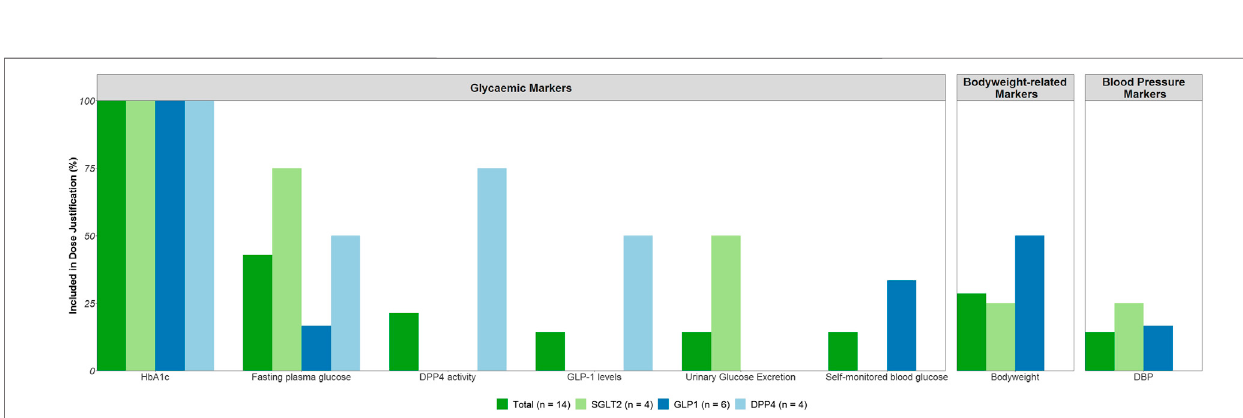
Frontiers in Pharmacology |